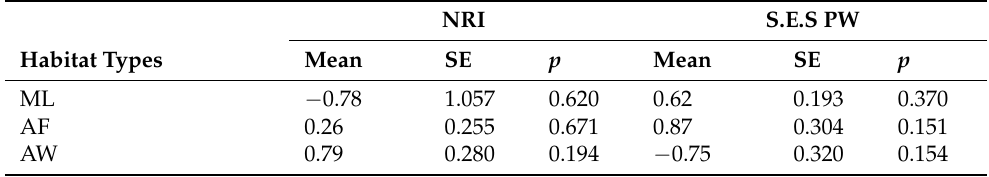
Figure 2. Phylogenetic ( a ) and functional ( b ) structures of communities in the three habitat types in Dianchi lakeside (mean ± SE). Table 3. Student’s t -test on the phylogenetic (a) and functional (b) structures differing from the null expectation in the three habitat